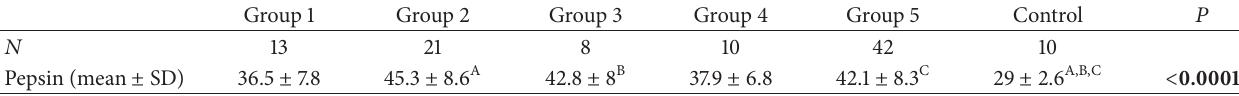
Table 2: BAL pepsin in wheezy infants based on the presence of GERD compared to healthy control.